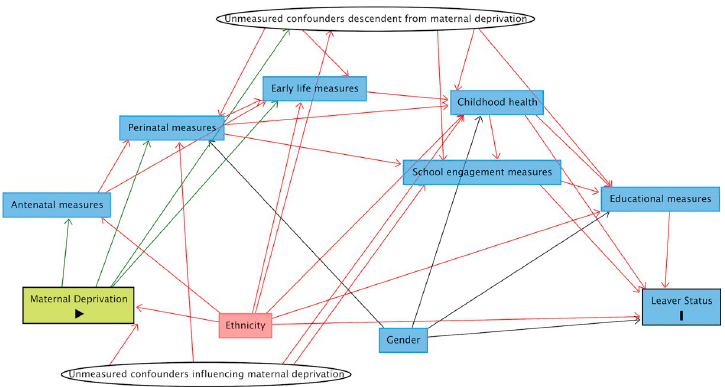
Fig 1. Simplified directed acyclic graph. Directed acyclic graph showing causal assumptions between grouped nodes.